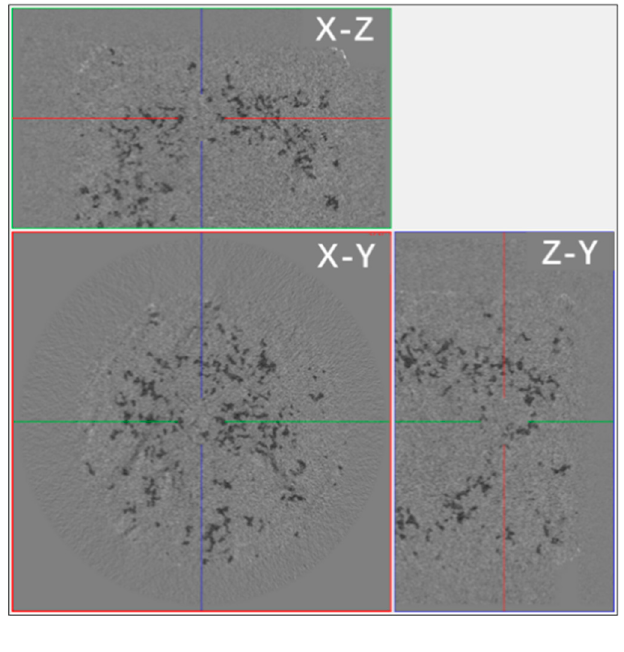
Figure 9. Images for the nuclear magnetic imaging of the Na 2 SO 4 solution sample at different drying times (the higher the brightness, the higher the water